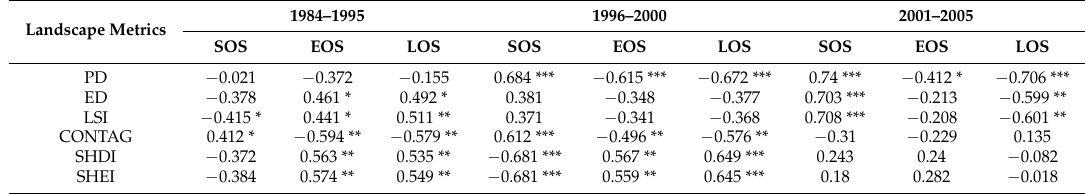
Table 6. Pearson correlation coefficients between SOS, EOS, and LOS of urban vegetation and landscape level pattern metrics for the time periods of 1984–1995, 1996–2000, and 2001–2005, respectively. Landscape